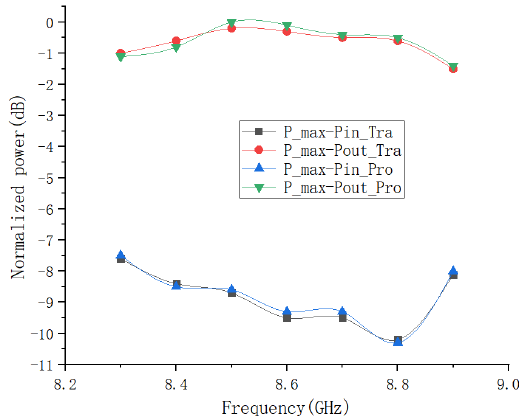
Figure 15. Normalized input and output power of the traditional and proposed power-amplifier systems.